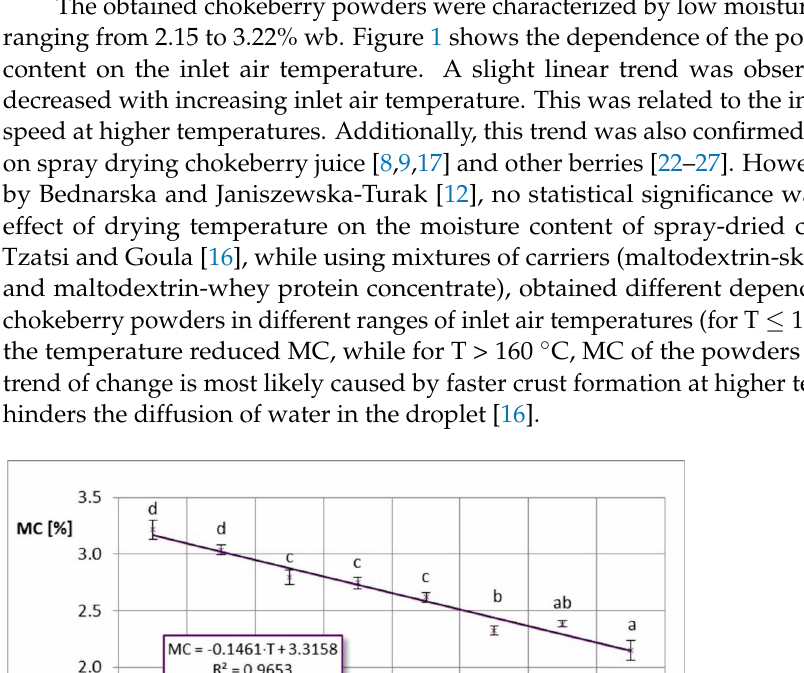
Figure 2. Moisture content (MC) in spray-dried chokeberry juice with different dry matter content in the feed solution (U d.m. ); (a, b, c, d — different letters show significant differences between mean values ( p ≤ 0.05)). 3.2. Powder Yield (PY) Powder yield (PY) is a very important indicator related to the efficiency and economy of the production process. It directly determines the level of raw material losses during the process, which should be as low as possible. In industrial practice, it is expected to maximize powder yield at least above 90%, and preferably above 97% [7]. In the case of